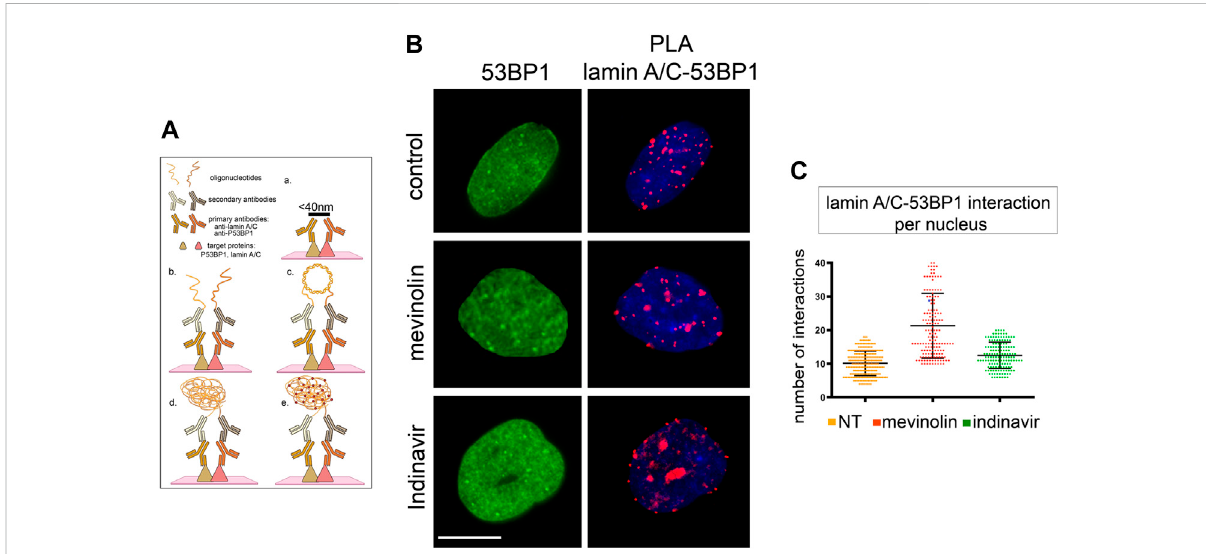
FIGURE 3 53BP1-laminA/Cbindinginhumandermal fi broblastsaccumulatingprelaminA, (A) SchematicrepresentationofPLAprotocolshowingprimary antibodies and interactors analysed in this study (created with BioRender.com). The maximum distance between interactors that allows direct binding and detection by PLA is indicated on the black bar in panel a. Binding of primary antibodies and secondary antibody-bound probes is shown in panel b. Ligase-catalysed oligonucleotide annealing is shown in c. Ampli fi cation of oligonucleotides is represented in d, incorporation of fl uorescent probes is represented in e. (B) 53BP1 localization and PLA of lamin A/C-53BP1 interactions in untreated, mevinolin- or indinavir-treated cells. 53BP1 was detected by immuno fl uorescence labeling with a speci fi cantibody (green). Interactions between lamin A/C and 53BP1 are revealed asredsignals.ChromatinwascounterstainedwithDAPI(blue).Bar,10 μ m. (C) DotplotshowingthenumberofPLAsignalspernucleusasdetectedin (B). Experiments wereconductedintriplicate,data analyzed werebasedonan average of100cells. Error bars, mean±SD.Comparisonbetweenthe groups was determined by using the one-way ANOVA